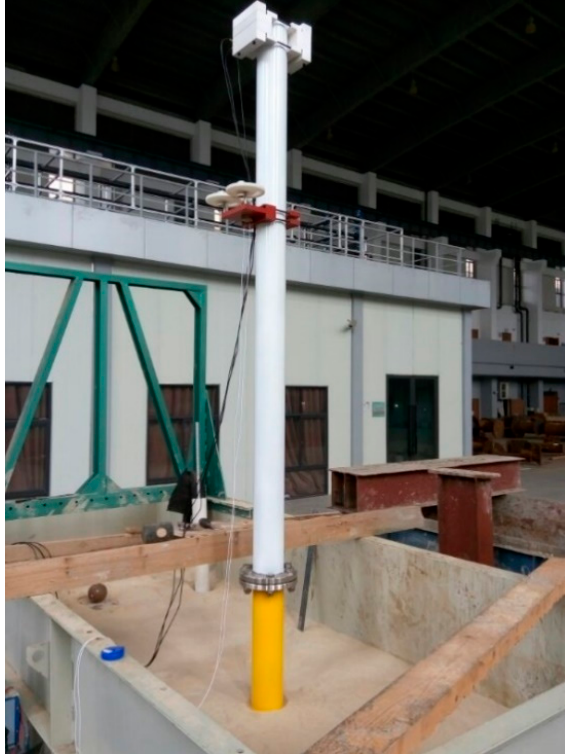
Figure 16. Examples of the Type 3 technique used in Zhejiang University (China).